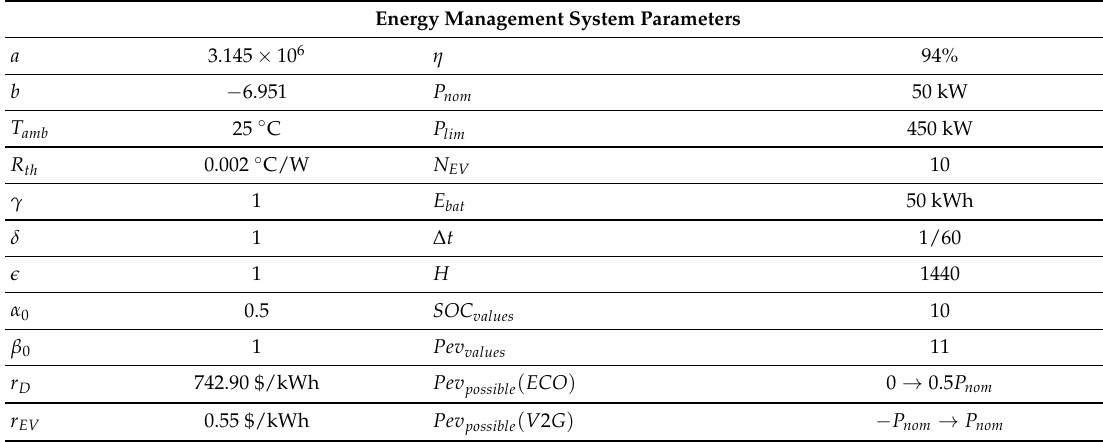
Table 1. Simulation and real-time emulation parameters.